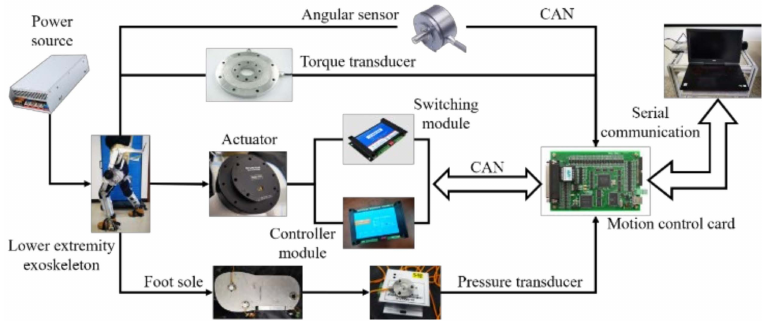
Figure 31. Control system diagram of lower-limb exoskeleton rehabilitation robot.